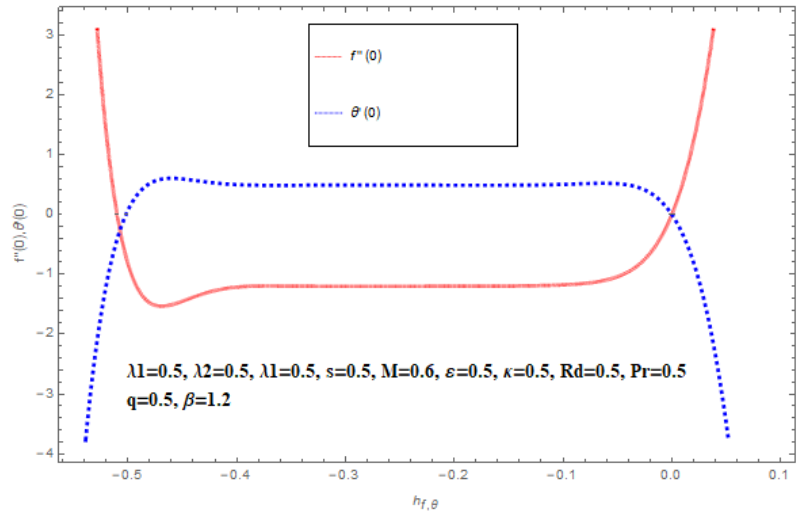
Figure 2. The combined h-curve graph of the velocity and temperature profiles. Table 1. Fast convergence of HAM (homotropy analysis method).